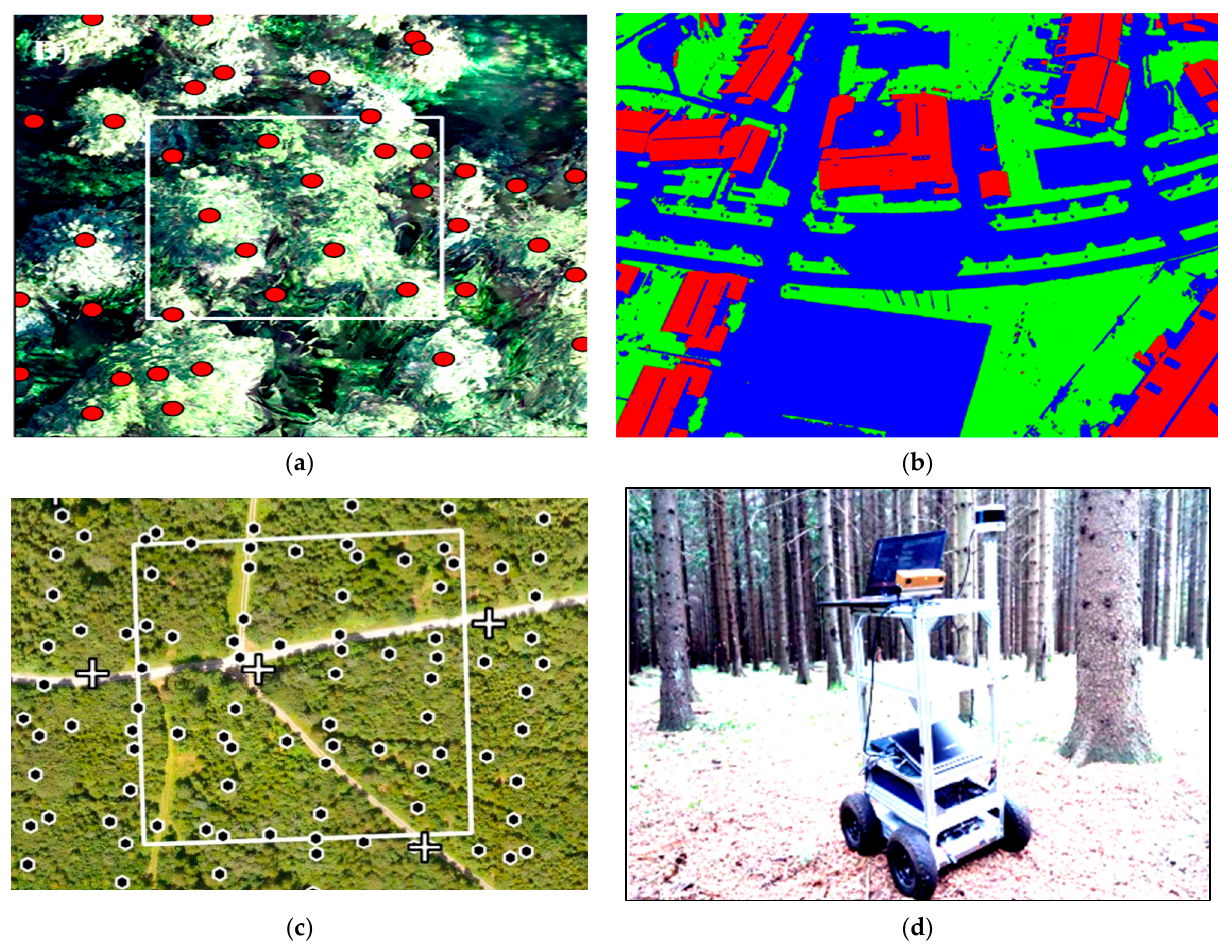
Figure 6. Typical applications of Tree quanti fi cation. ( a ) Individual tree detection (Figure from [100]). ( b ) Result of image segmentation (Figure from [102]). ( c ) Tree height growth measurements (Figure from [103]). ( d ) Mobile platform (Figure from [109]).